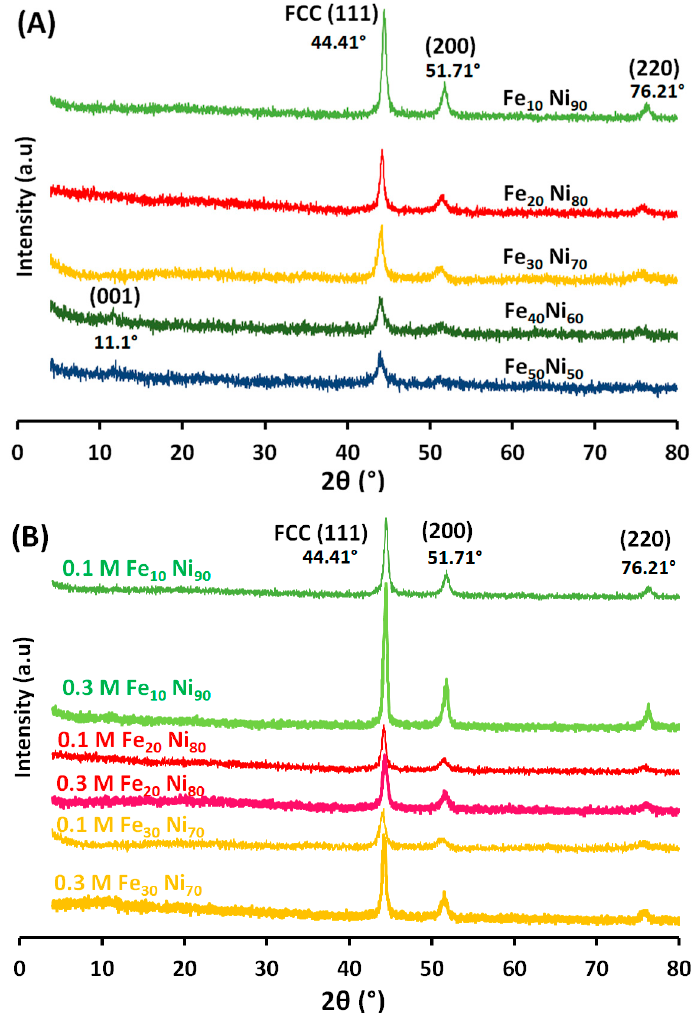
Figure 7. XRD pattern of the prepared iron-nickel alloys using ( A ) different iron-nickel molar ratio with 0.1 M metal concentration and 80 mL reaction volume, ( B ) 10 to 30% iron molar ratio at both 0.1 and 0.3 M metal concentration and 80 mL reaction volume. Reference condition: 1400 rpm, and 95–98 °C.